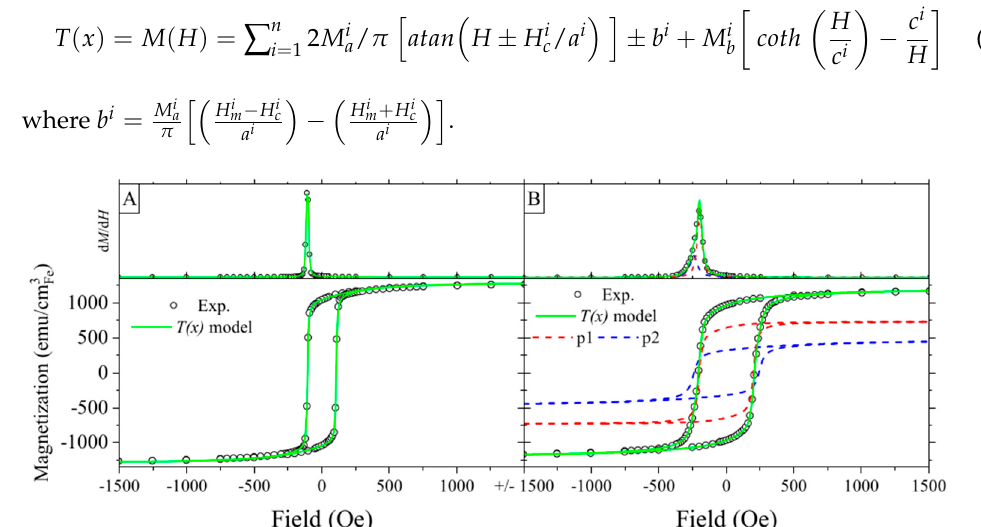
Figure 3. Magnetization curves (bottom graphs) for the S0 sample as-prepared ( A ) and annealed ( B ), and derivatives of the upper branch of hysteresis loops (top graphs). Calculated hystereses of different magnetic phases are shown with dashed lines. Loops were measured in the in-plane geometry.